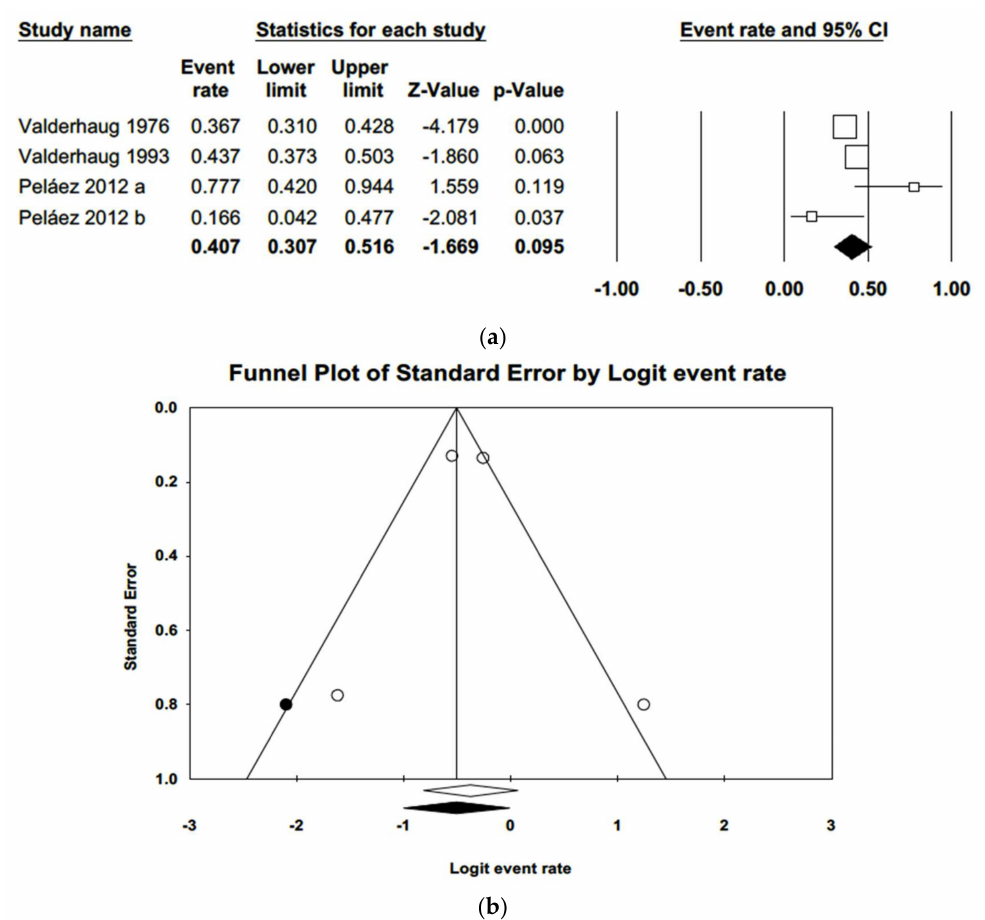
Figure 11. ( a ) Forest plot of meta-analysis % of samples su ff ering gingival margin migration. ( b ) Funnel plot with observed and imputed